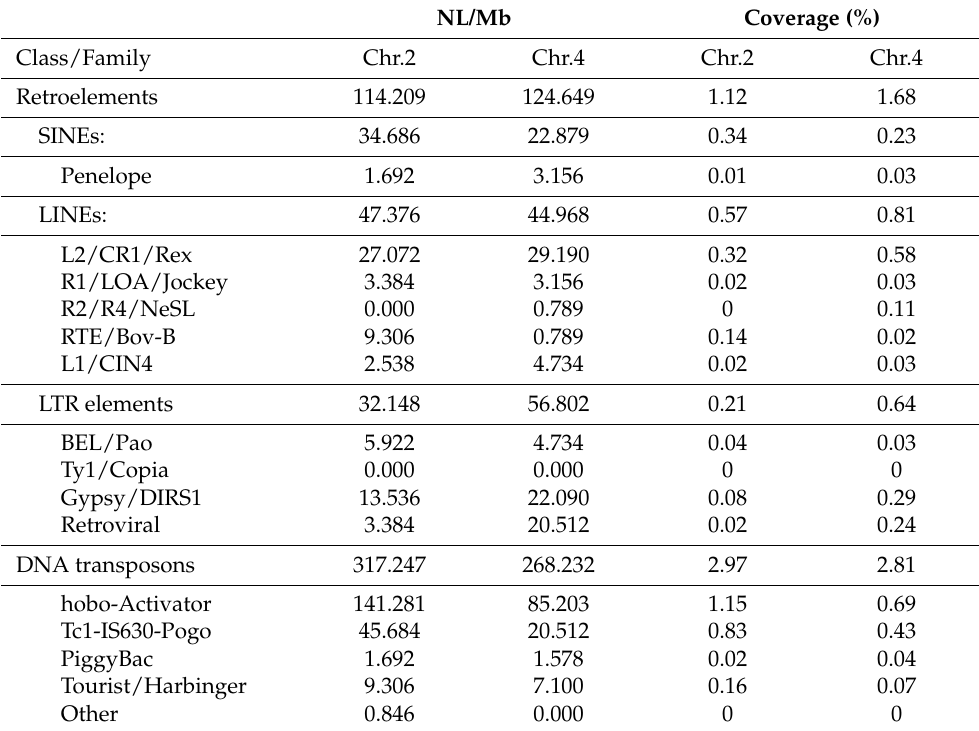
Table 2. Summary of repeat types present in the chromosomes 2 and 4 of Solea senegalensis.